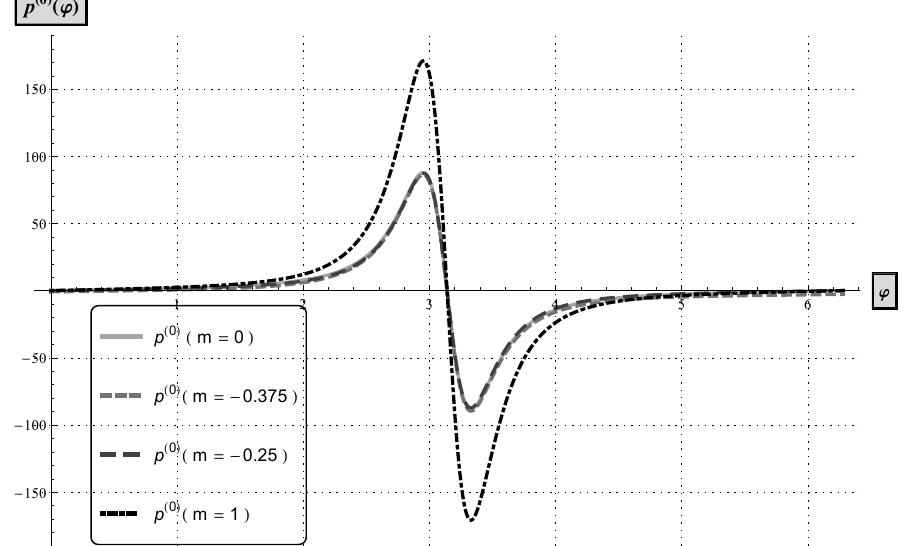
Figure 9. Pressure distributions computed from the classical Reynolds equation, p ( 0 ) ( θ ) ( m = 0 ) , and from the power-law system of Reynolds type equations, p ( 0 ) ( θ ) ( m = − 0.375, − 0.25, 1 ) , with χ =